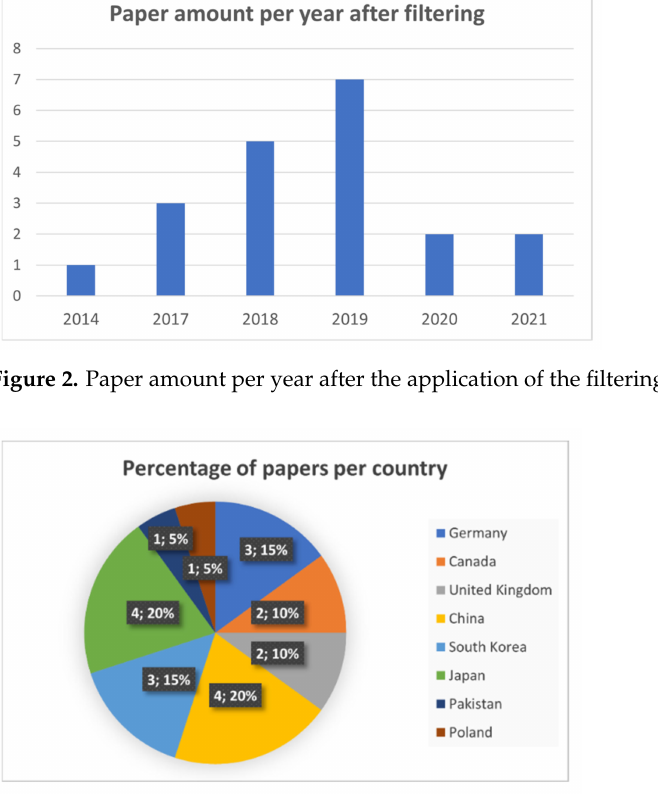
Figure 3. Percentage of papers per country with publications that fulfill the quality criteria